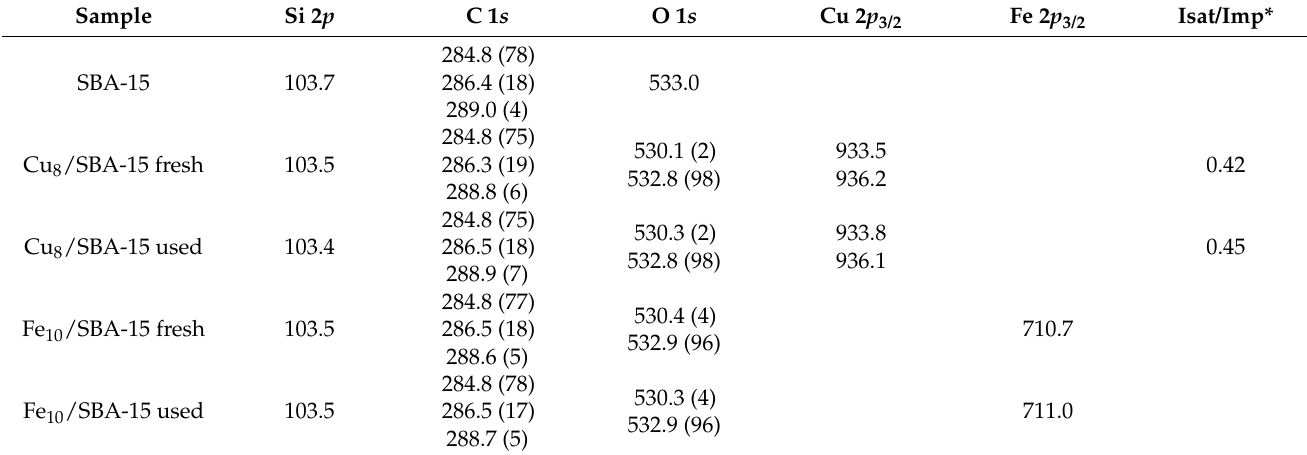
Table 3. Si 2 p , C 1 s , O 1 s , Cu 2 p 3/2 , Fe 2 p 3/2 binding energy values (in eV) of the selected